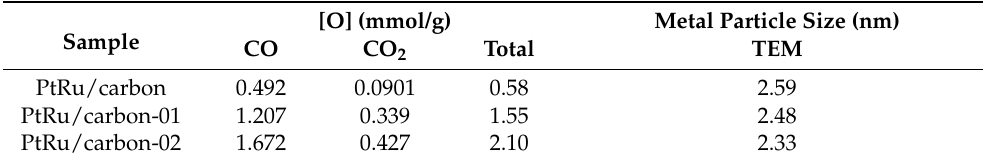
Table 4. Pt particle size of the sample supported by H 2 O 2 -modified carbon black and reduced by